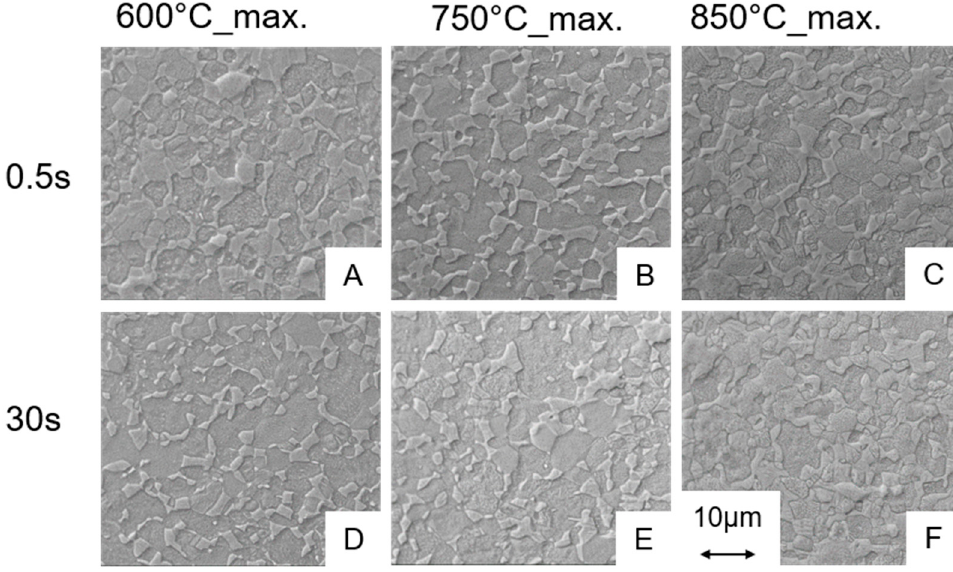
Figure 6. SEM images of the microstructures for the experiments at 600, 750 and 850 °C for holding times of 0.5 ( A – C ) and 30 s ( D – F ) in combination with maximum cooling. The heating rate was 1000 °C/s.